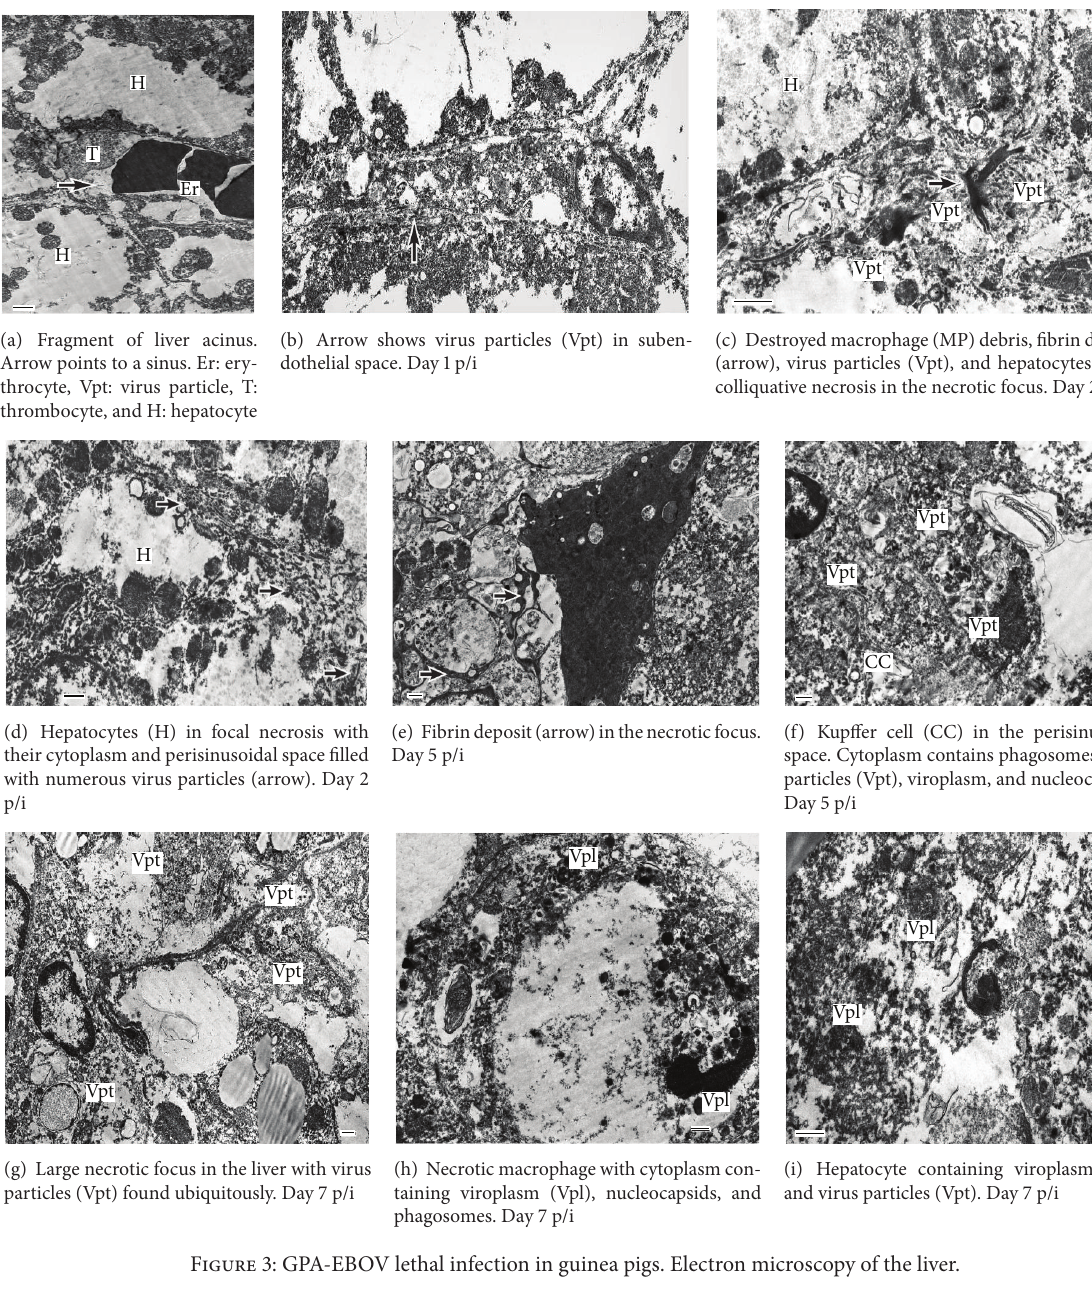
Figure 3: GPA-EBOV lethal infection in guinea pigs. Electron microscopy of the